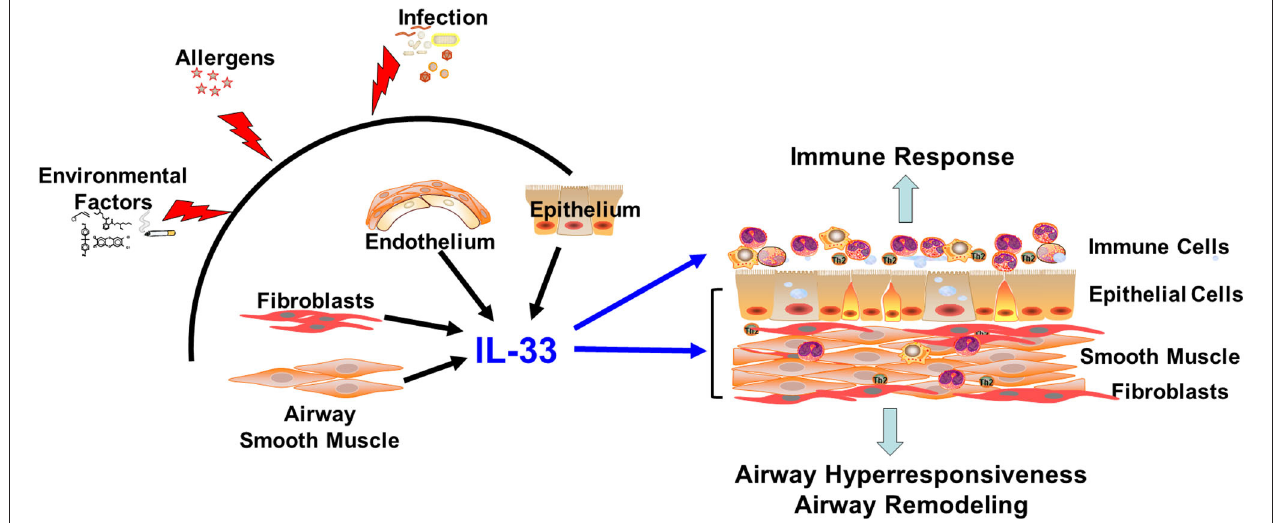
FIGURE 1 | IL-33 in the lung. Infection, allergens, and environmental factors induce IL-33 production and release from resident lung tissue cells. Extracellular IL-33 activates immune cells and non-hematopoietic lung cells to promote immune responses, airway hyperresponsiveness and airway remodeling: aspects relevant to diseases such as